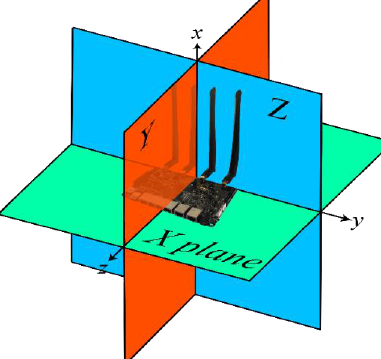
Figure 11. Planes under study.